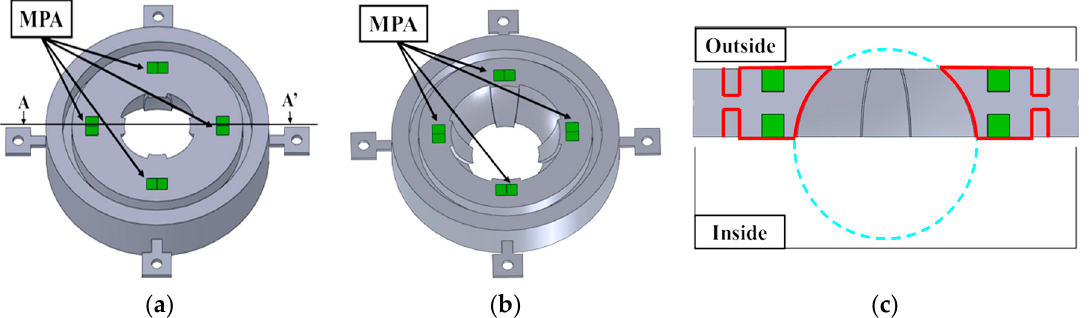
Figure 2. New stator construction using SUS304 steel. ( a ) Outside; ( b ) Inside; and ( c ) Cross-section A-A’.